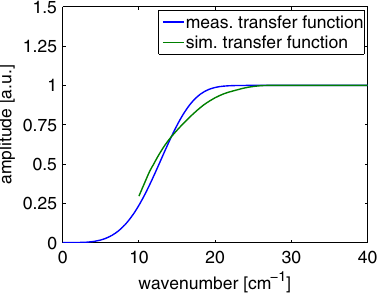
FIG. 4. The simulated (green curve) as well as a fit to the measured transfer function (blue curve) as a function of wave number.